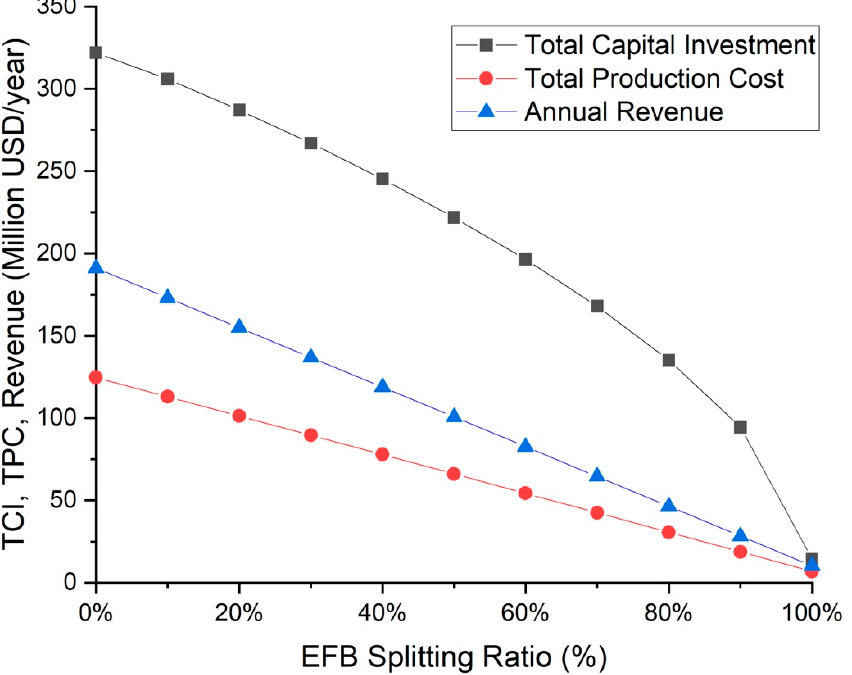
Figure 4. Changes in TCI, TPC, and annual revenue (at full capacity) at different EFB splitting ratios to pellet production.